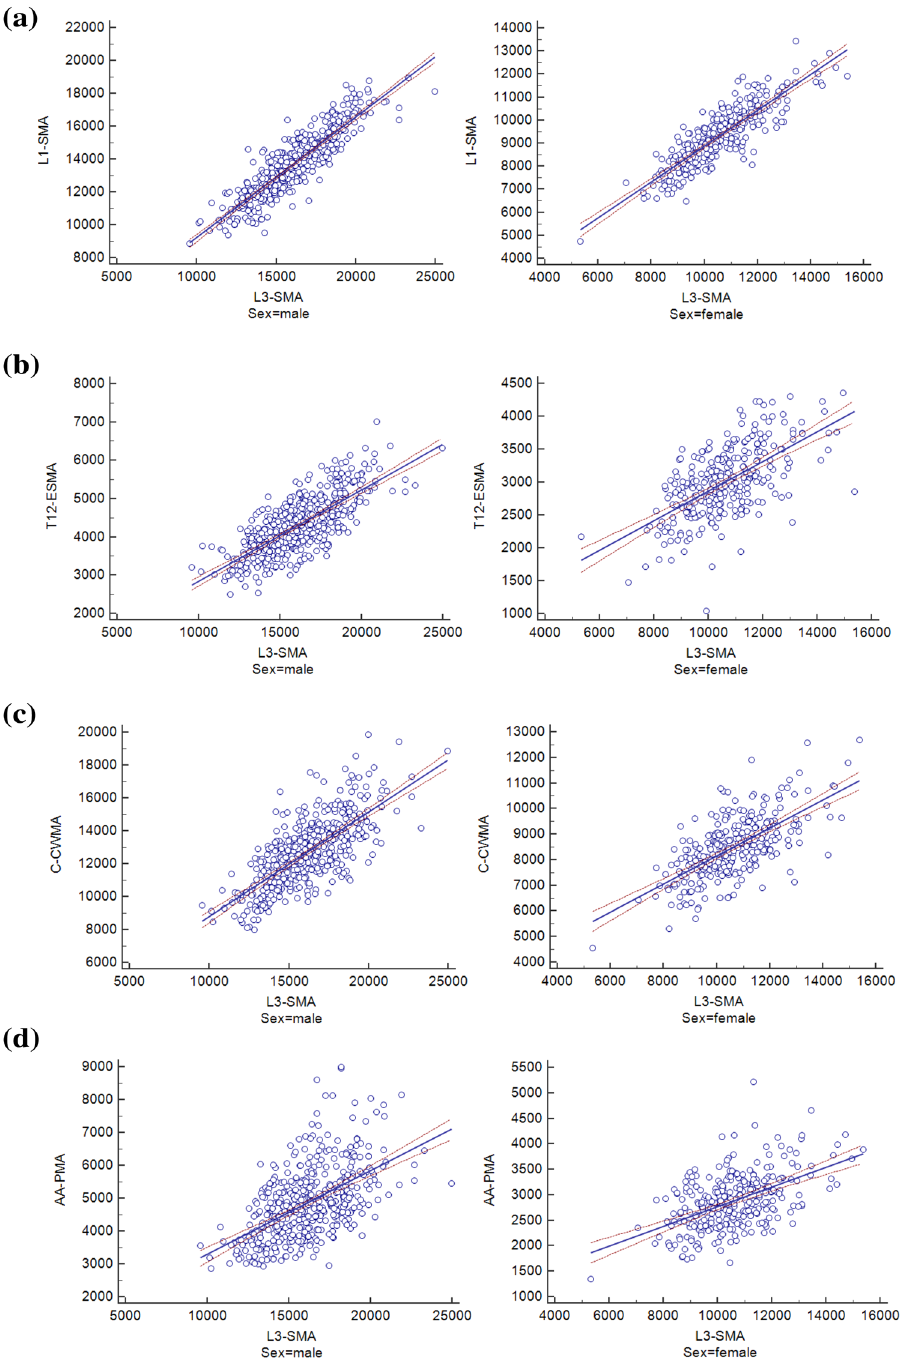
Figure 1. Correlation of skeletal muscle area (SMA) between L3-SMA and variable anatomic landmarks in chest CT: ( a ) L1-SMA (men, R 2 = 0.7920; women, R 2 = 0.7396), ( b ) T12-ESMA (men, R 2 = 0.5557; women, R 2 = 0.3834), ( c ) C-CWMA (men, R 2 = 0.5306; women, R 2 = 0.4427), and d) AA-PMA (men, R 2 = 0.3052; women, R 2 =